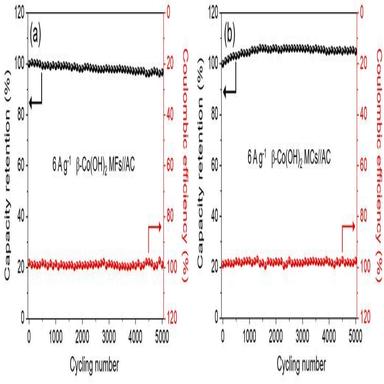
Cycling performance of (a) β-Co(OH)2 MFs//AC HSC and (b) β-Co(OH)2 MCs//AC HSC during 5000 cycles.